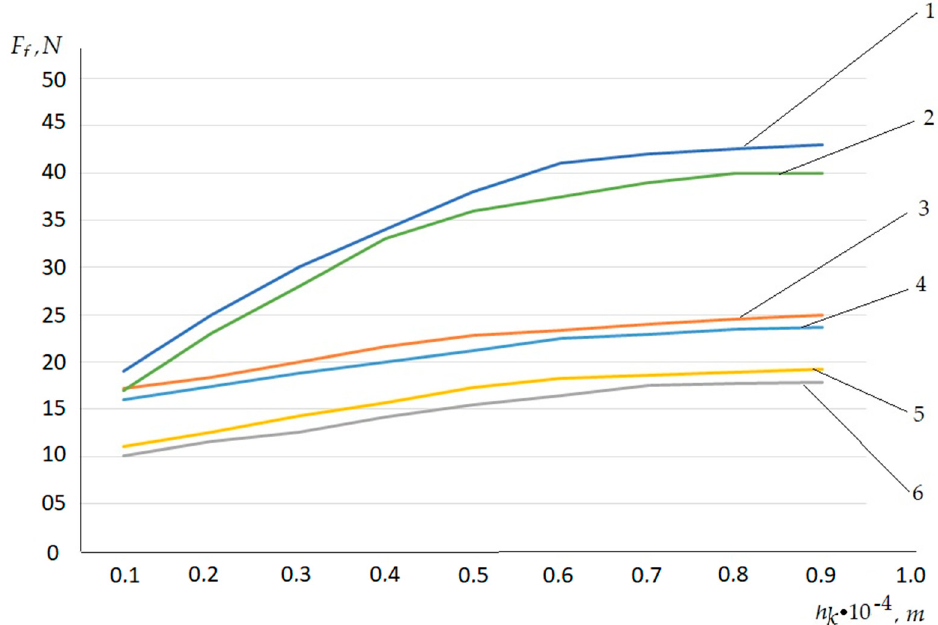
Figure 6. Dependences of the polymer film thickness film h k on fixing force F f . (1) Theoretical data for fabric denim, (2) experimental data for fabric denim, (3) theoretical data for genuine beef skin, (4) experimental data for genuine beef skin, (5) theoretical data for artificial leather SK-2, and (6) experimental data for artificial leather SK-2.